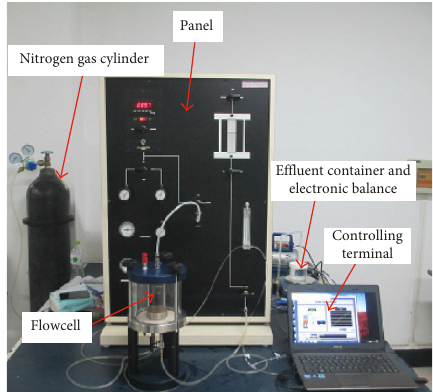
Figure 2: The unsaturated soil transient hydraulic characteristic cyclic test